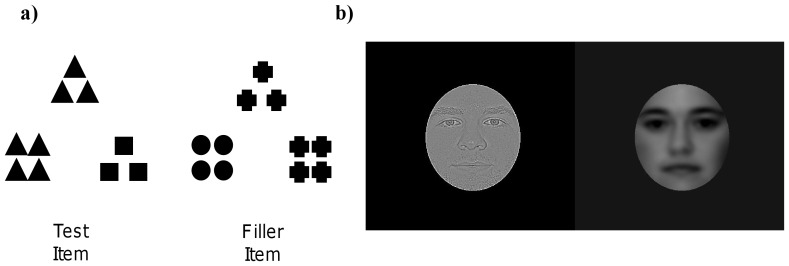
Sample stimuli from the dispositional and manipulation global/local tasks.(a) Sample stimuli from the dispositional global/local shape task. The test triad on the left contains both a global and a local option, whereas the filler triad on the right has only one possible answer, and was not used to measure global/local processing. (b) Sample stimuli from the global/local face manipulation task. A HSF (local) face on the left side and a LSF (global) face on the right.